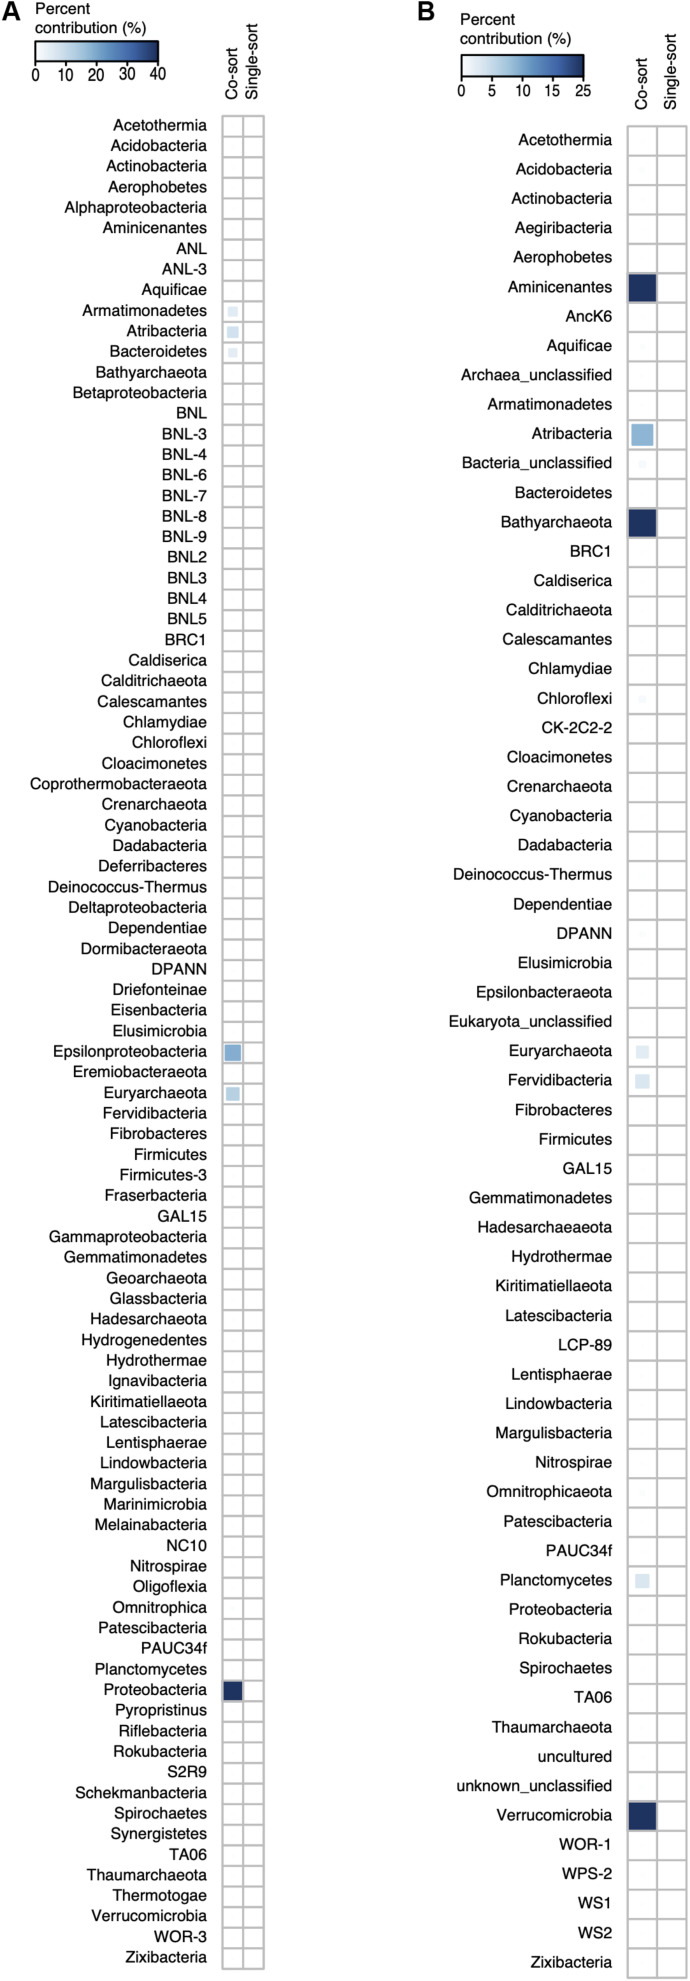
Contribution of individual phyla to the Chi-square statistic from cell co-sorting analyses based on checkM (A) and 16S rRNA genes (B). Phylum assignments are based on concatenated-alignment based phylogenomic tree (Figure 2) in (A) and from 16S rRNA classification in (B).